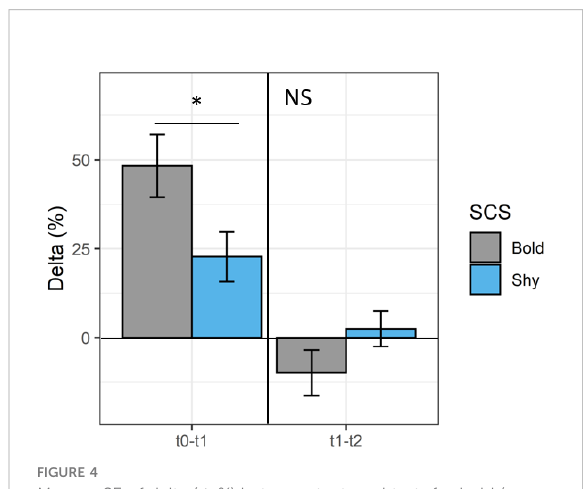
FIGURE 4 Mean ± SE of delta ( D , %) between t 0 − t 1 and t 1 − t 2 for bold (gray, n = 9) and shy fi sh (blue, n = 9). Statistical differences are indicated in the fi gure (Wilcoxon test; * p < 0.05) or NS (indicating not signi fi cant) for each experimental period ( t 0 − t 1 or t 1 − t 2